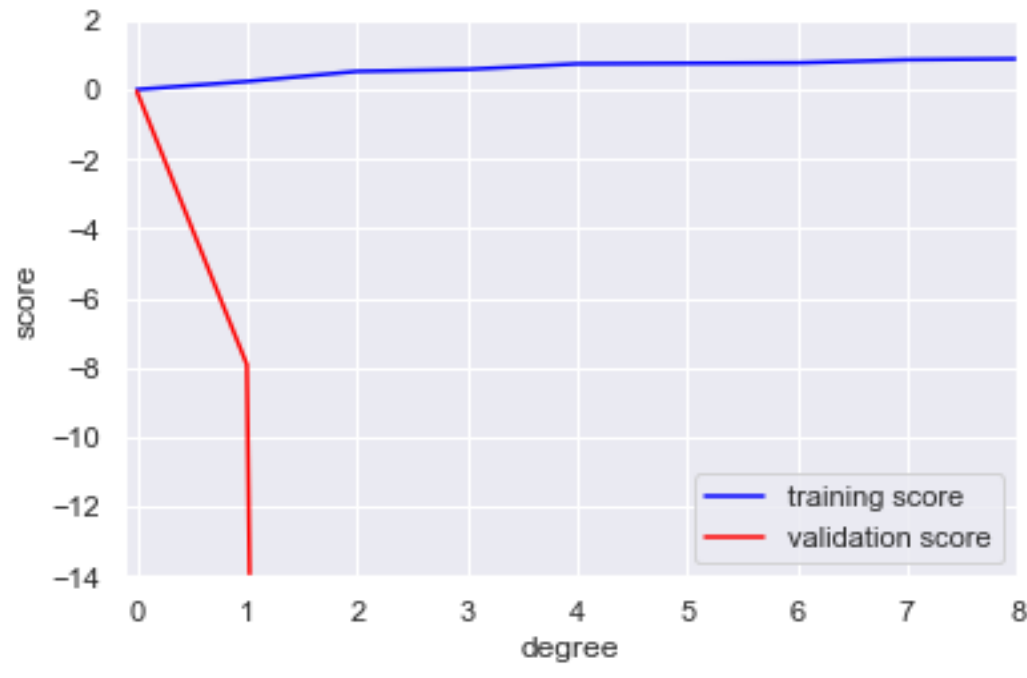
Figure 4. The variance scores for the polynomials of the degree (5 th -8 th